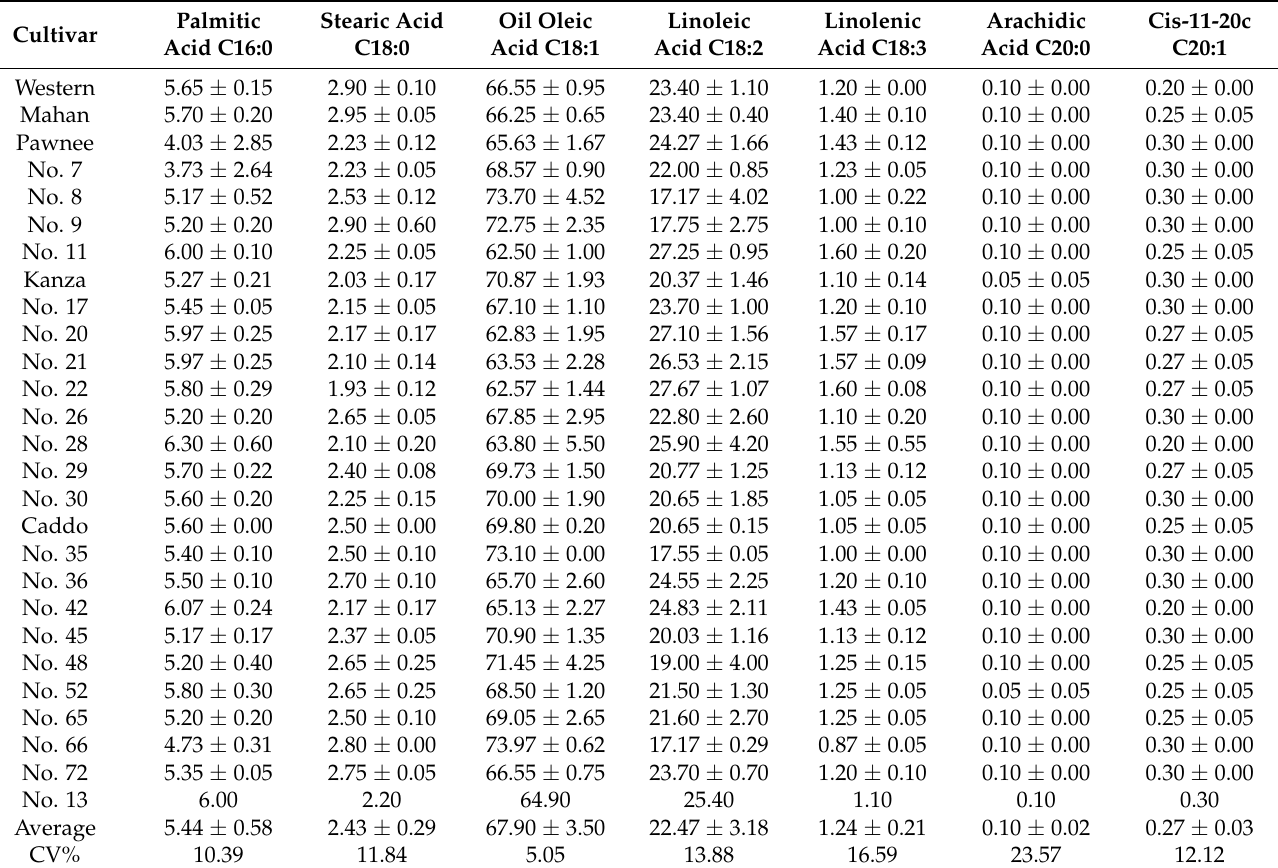
Table 3. Fatty acid composition (%) of the pecan